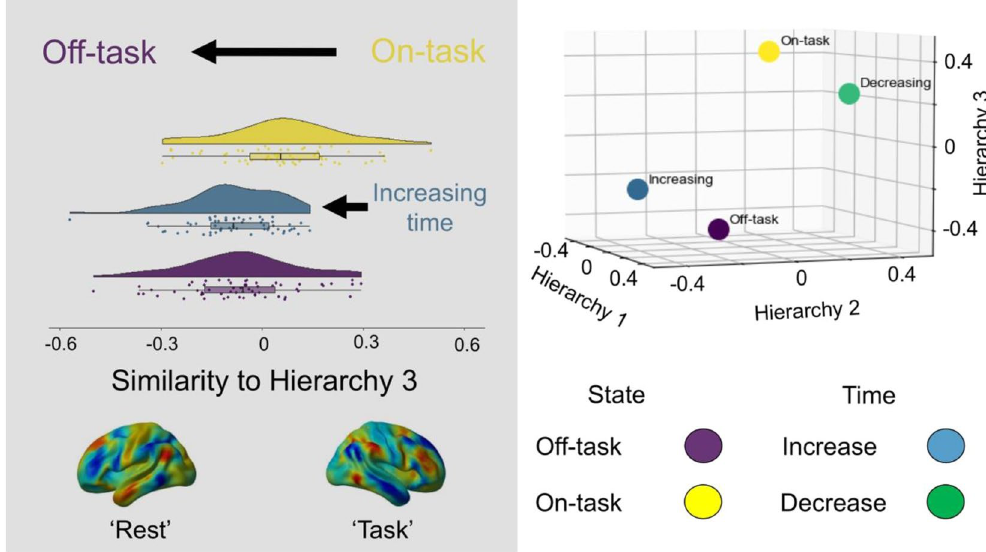
Figure 3. Neural dynamics associated with the passage of time and differences between on- and off-task thought are associated with common reductions in task positive regions. Brain activity during on-task thought looks similar to the task-positive end of the task-related gradient, as do regions that decrease over time. This suggests that over time a neural motif emerges that is similar to that seen during off-task thought, and mimics the patterns seen in the absence of a task (left). These same maps can be represented in a three-dimensional space based on each hierarchy (top right). In this plot it can be seen that neural patterns that decline over time (green), and patterns seen during on task states (yellow), are located in the top right quadrant. In contrast, patterns that increase over time (blue) and those associated with off task thought (purple) are located in the bottom right quadrant. Note that the values in the 3D plot are r-values from the group level results (including motion as a covariate) and are therefore related to, but not the same as, the beta-weights representing each subject’s similarity score displayed in the raincloud plots 29